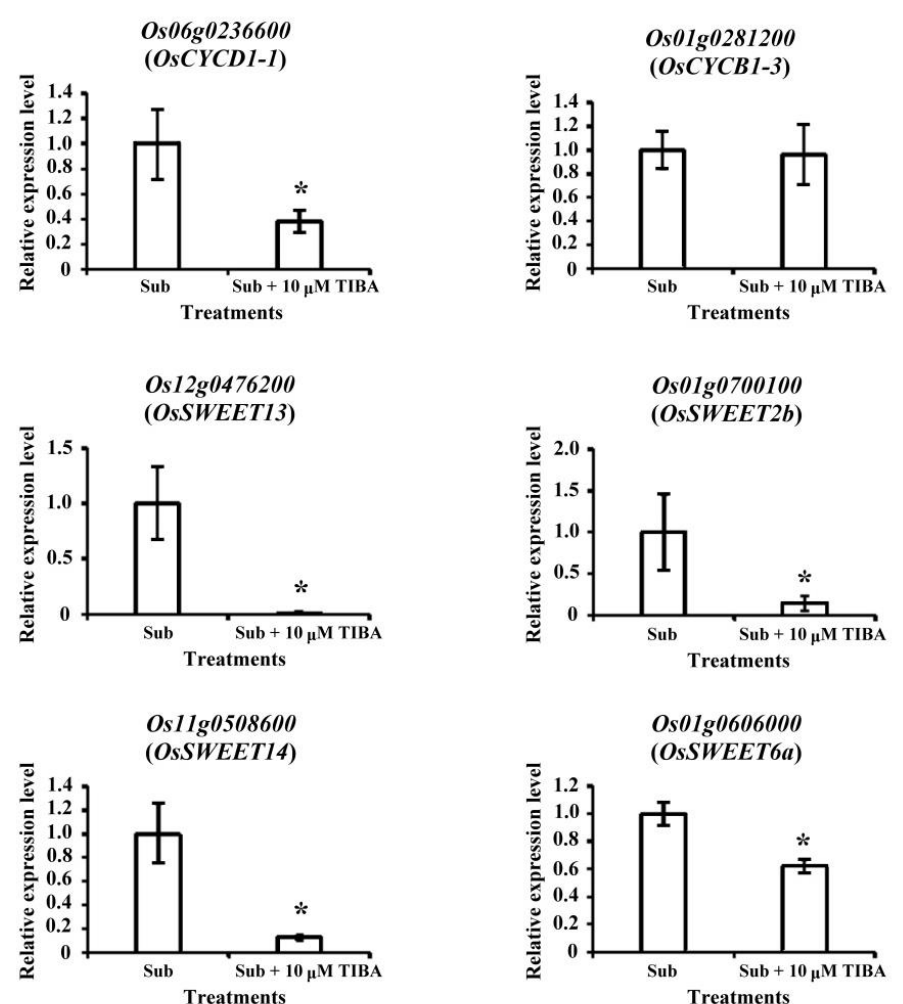
Figure 4. Transcript levels of development-associated genes regulated by auxin signaling in submerged coleoptiles. Total RNA was isolated from the coleoptiles after submergence treatment with or without 10 µM 2,3,5-triiodobenzoic acid (TIBA) for 5 days. Relative expression levels of Os06g0236600 ( OsCYCD1-1 ), Os01g0281200 ( OsCYCB1-3 ), Os12g0476200 ( OsSWEET13 ), Os01g0700100 ( OsSWEET2a ), Os11g0508600 ( OsSWEET14 ), and Os01g0606000 ( OsSWEET6b ) were determined while using quantitative RT-PCR. These genes were calculated and normalized with ubiquitin gene ( Os02g0634800 ) as an internal standard. Values are presented as mean ± standard deviation based on 30 coleoptiles of each treatment obtained from six biologically independent experiments. * p < 0.05 versus the submergence treatment value (Student’s t -test).